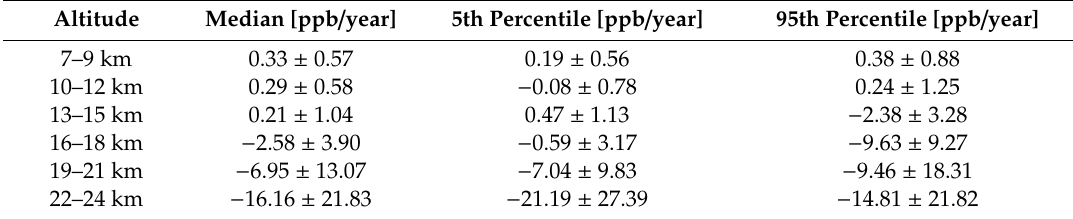
Table 3. Statistical analysis of ozone at di ff erent